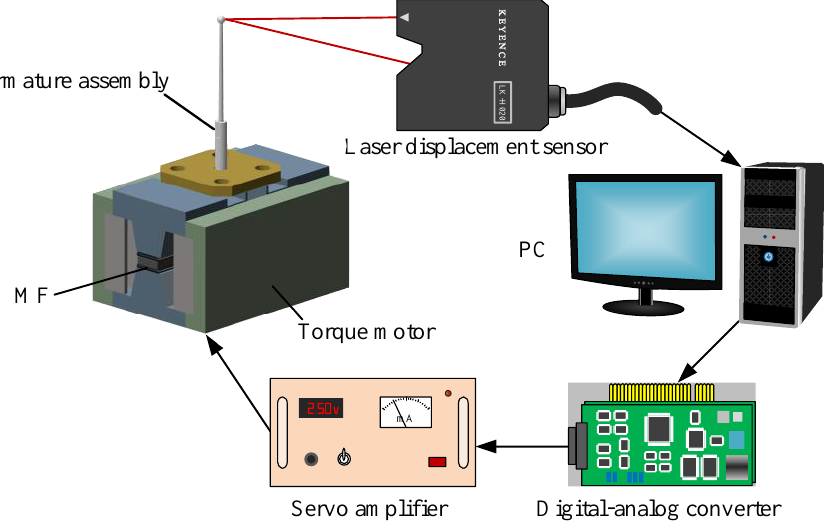
Figure 3. Experimental setup for driving torque motor and measuring dynamic response of armature assembly.